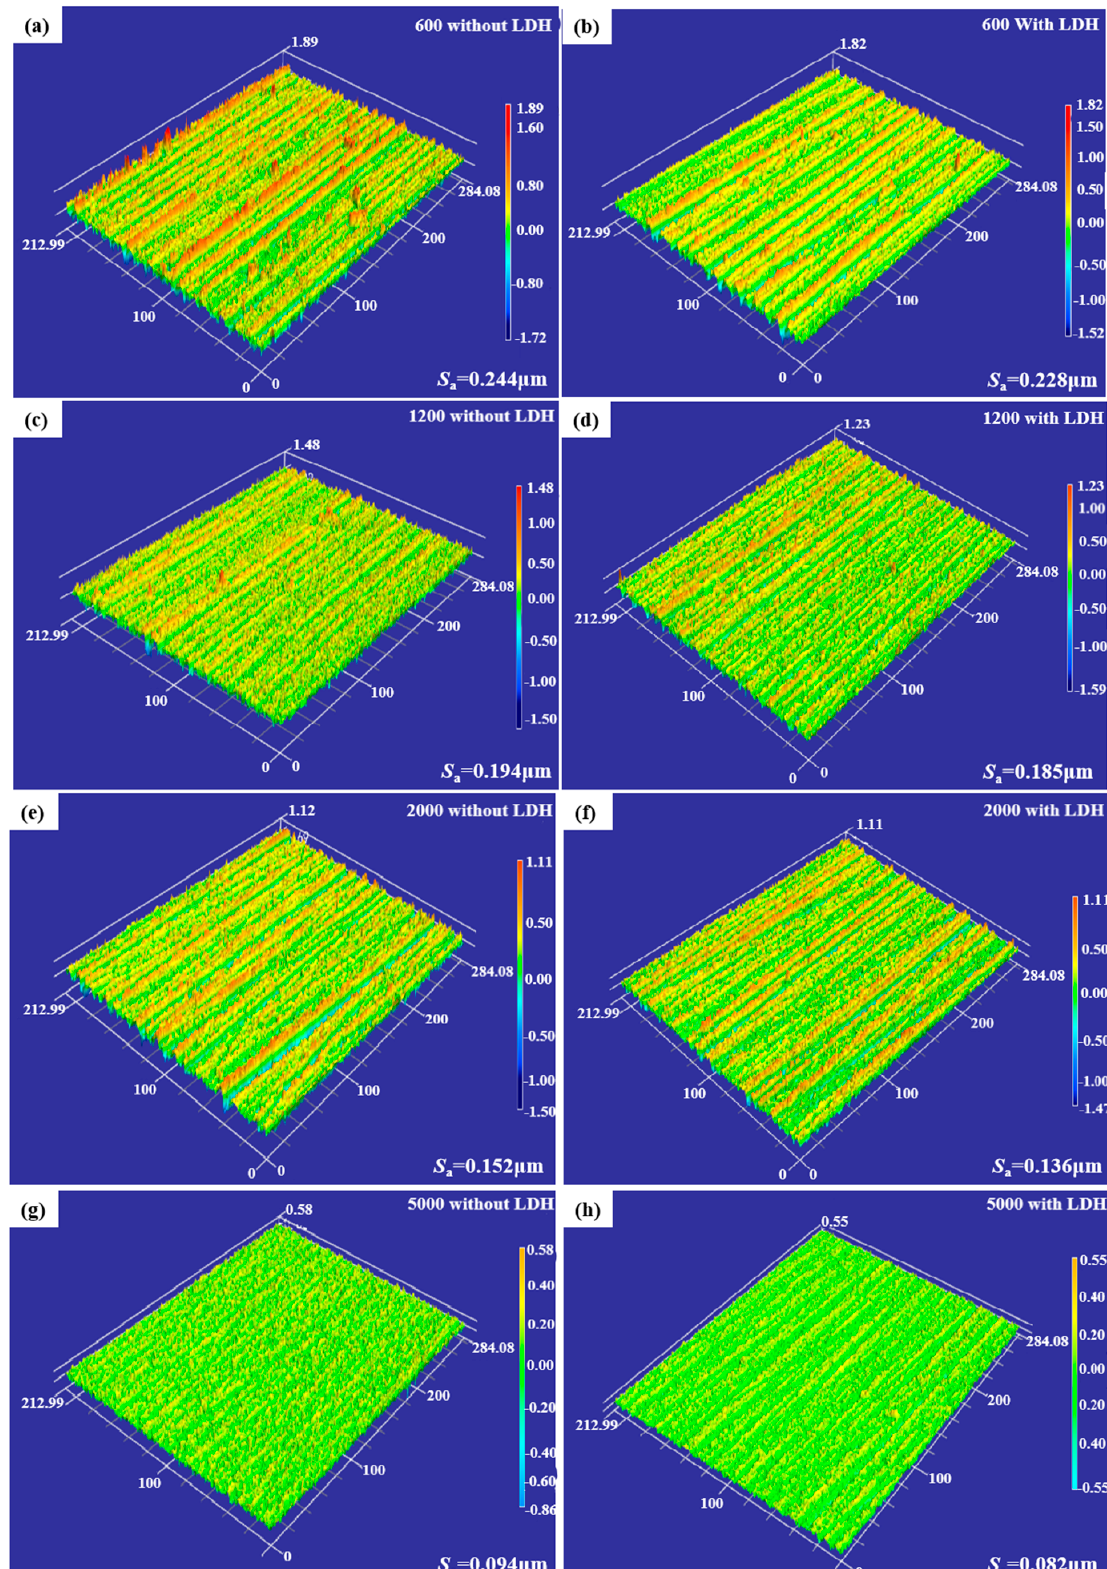
Figure 1. Surface roughness images of magnesium alloy substrates without and with ZnAl-LDH films: ( a , b ) 600; ( c , d ) 1200; ( e , f ) 2000; and ( g , h ) 5000.